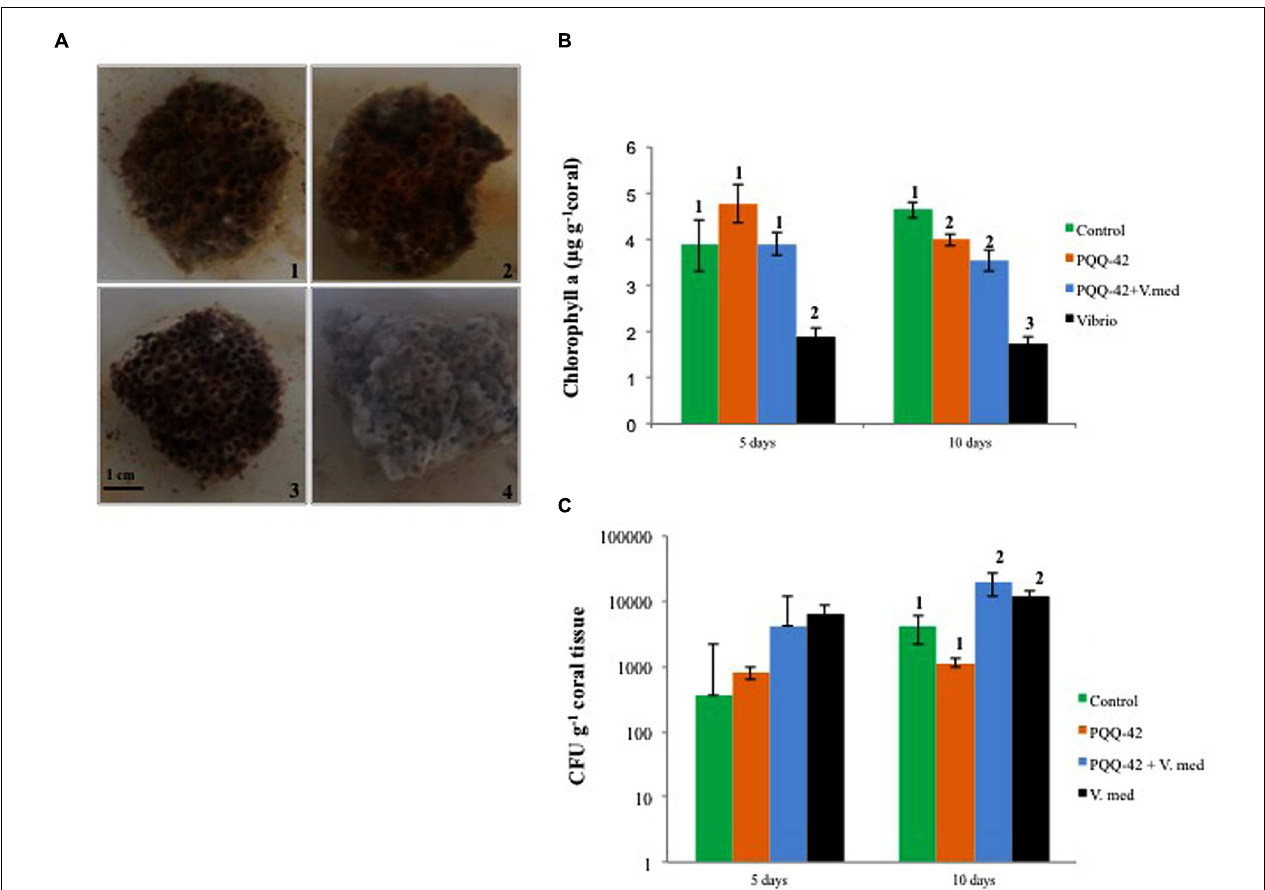
FIGURE 3 | Oculina patagonica coral colonies after 10 day’s treatment showing the varying extent of bleaching depending on the bacterium added [1: Cell-free MB medium (control), 2: PQQ-42, 3: PQQ-42 + V. mediterranei VibC-Oc-097, 4: V. mediterranei VibC-Oc-097]. Scale bar, 1 cm (A) . Levels of chlorophyll a (B) and number of vibrios (CFU g − 1 C) in the tissue of O. patagonica after 5 and 10 day’s treatment. Error bars represent one standard deviation. Groups defined by post hoc SNK test after ANOVA ( p -value < 0.05) were done and are showed by